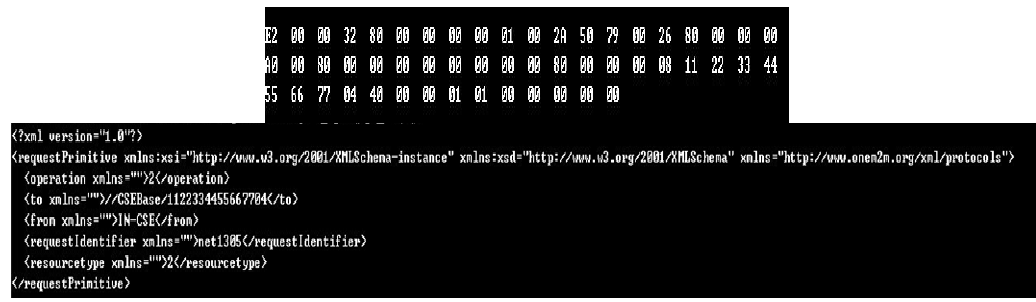
Figure 15. Screen captures of connection establishment (Conversion of an ISO/IEEE 11073 Association Request message into a oneM2M Retrieve primitive Request message).